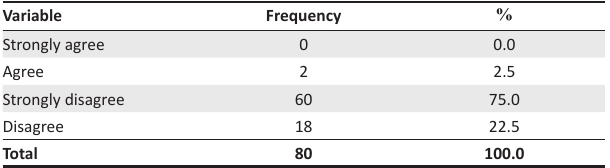
TABLE 2: Lack of performance incentives is not negatively affecting employees’ performance.